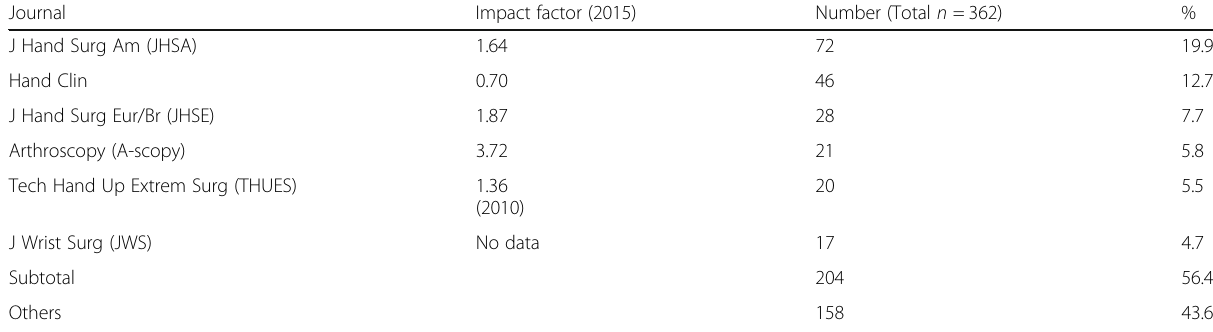
Table 2 Distribution of publications in journals (numbers, percentage) and their impact factors Journal